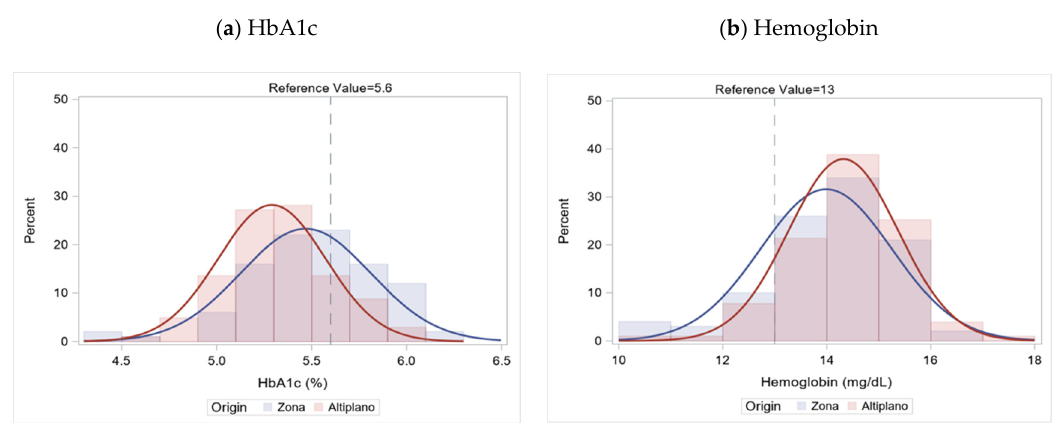
Figure 1. ( a ) Distribution of HbA1c and ( b ) Distribution of Hemoglobin, by worker origin, mid-harvest, January 2019. trended lower among Zona workers (14.0 g/dL (SD: 1.3)) compared to Altiplano (14.3 g/dL (SD: 1.1)), p = 0.04. Thirteen percent of workers (n = 27) in the cohort were anemic.